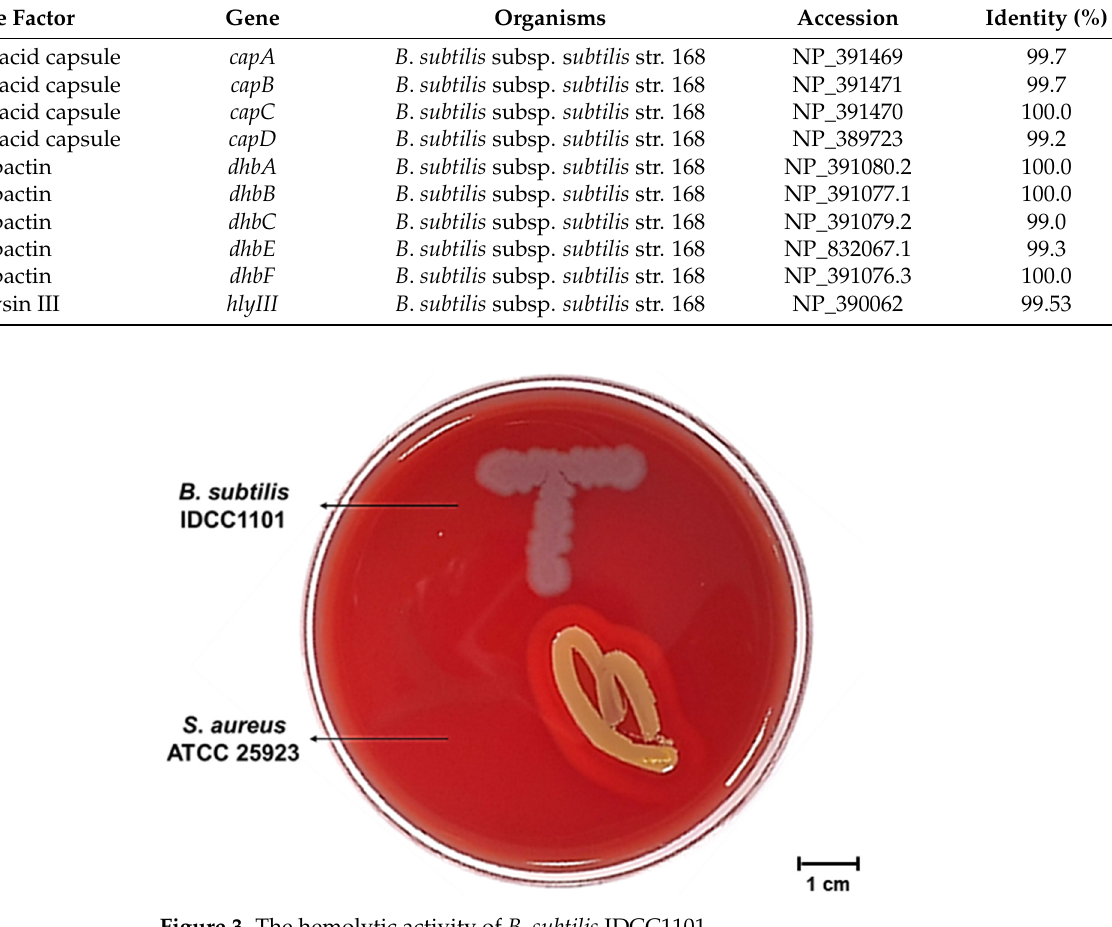
Figure 3. The hemolytic activity of B . subtilis IDCC1101. Table 4. Detection of enterotoxin genes in B . subtilis IDCC1101.